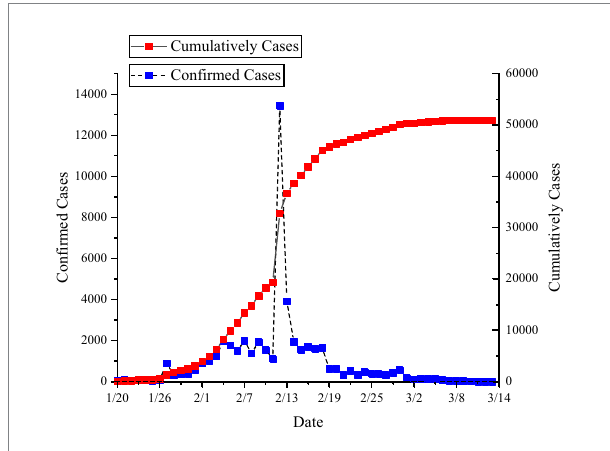
FIGURE 3 Schematic diagram of COVID-19 infection numbers in Wuhan